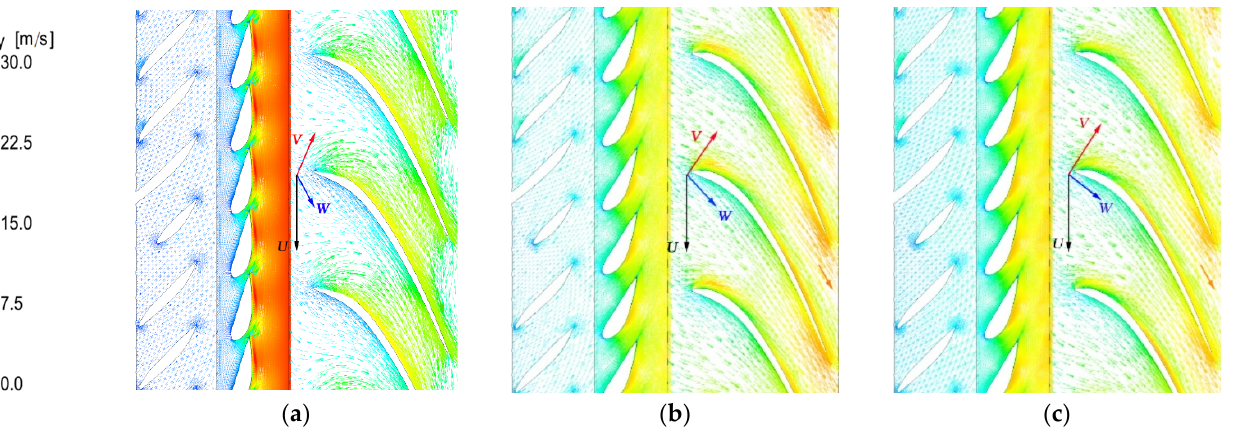
Figure 4. Velocity vector at the maximum head. ( a ) OP4, ( b ) OP5, and ( c ) OP6. The cavitation volume fractions on the flow section at the blade heights of SPAN = 0.1, SPAN = 0.5, and SPAN = 0.9 at the rated head and maximum head, respectively, are provided, as shown in Figure 5, to demonstrate the cavitation situation in the runner intuitively and clearly. At the small load operating point, serious cavitation occurs in the blade outlet near the crown (SPAN = 0.1). In addition, cavitation bubbles almost occupy the entire flow passage in this area, whereas there is almost no cavitation bubble in the runner passage in the middle area and near the band (SPAN = 0.5 − 0.9). On the other hand, there were a few cavitation bubbles at the high-efficiency operating point, and cavitation only occurred near the band (SPAN = 0.9) at the blade outlet edge. Meanwhile, the cavitation area at the blade outlet at the large-load operating point is similar to that under a 100% output, but the cavitation degree is relatively high. In general, the effect of cavitation generated at a small-load operating point is completely different from that at the high- efficiency and the large-load operating points, which has a significant influence on the state of the fluid flowing into the draft tube. The effect of cavitation at the maximum head is slightly more significant than that at the rated head. ( f ) Figure 5. Cavitation volume fractions at rated head and maximum head. ( a ) OP1, ( b ) OP2, ( c ) OP3, ( d ) OP4, ( e ) OP5, and ( f ) OP6.